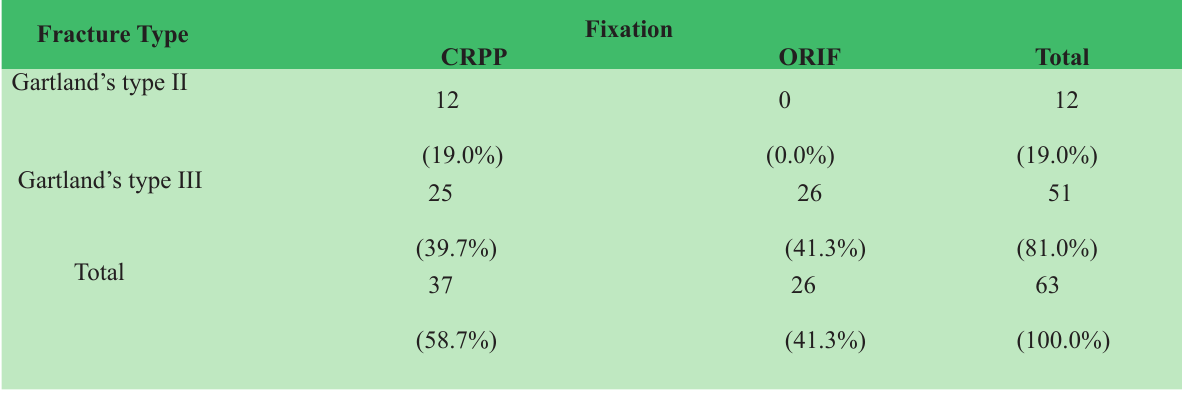
Table 2:Gartland’s Fracture Type versus Type of Fixation Fracture Type